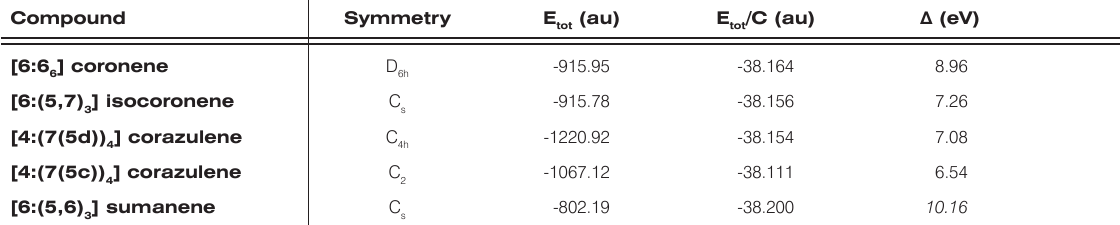
, total energy per number of C atoms E tot